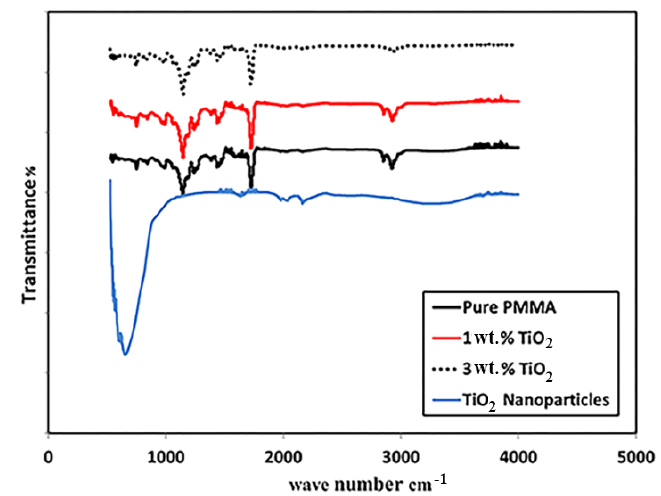
Figure 2. Fourier transform infrared spectra of the pure PMMA and PMMA/2 wt. % TiO 2 and the PMMA/3 wt. % TiO 2 nanocomposites.